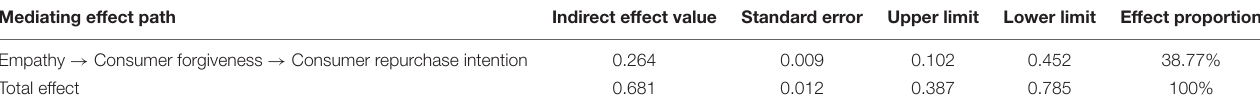
TABLE 6 | Test results of mediating effect. Mediating effect